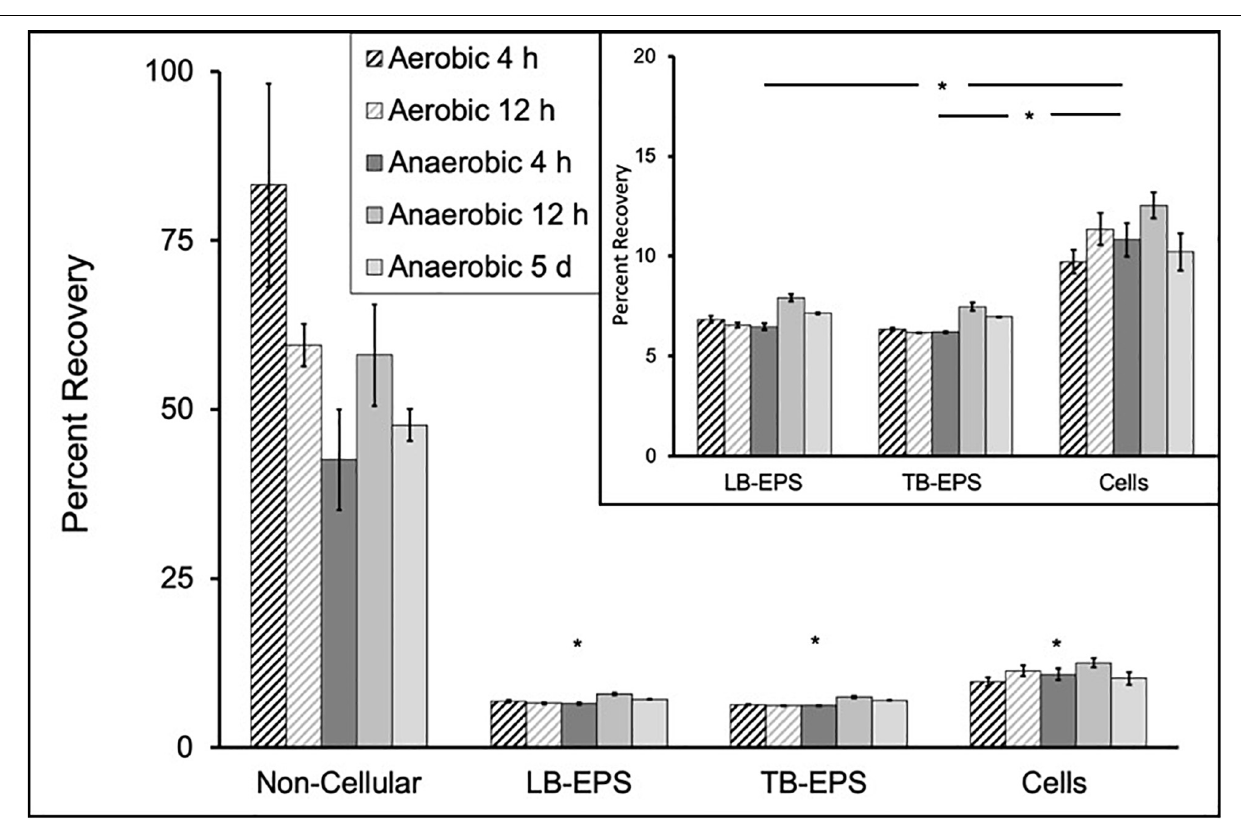
FIGURE 5 | The distribution of nano-PS in the four components of the exposed bacterial culture after exposure to 150 mg/L nano-PS, including the non-cellular growth broth, which is significantly greater ( p < 0.05) than lightly bound (LB)-EPS, tightly bound (TB)-EPS and association with cells. Inset shows statistical comparison of the nano-PS in LB-EPS and TB-EPS to the cells (* p < 0.05). Error bars represent the SEM of triplicate biological